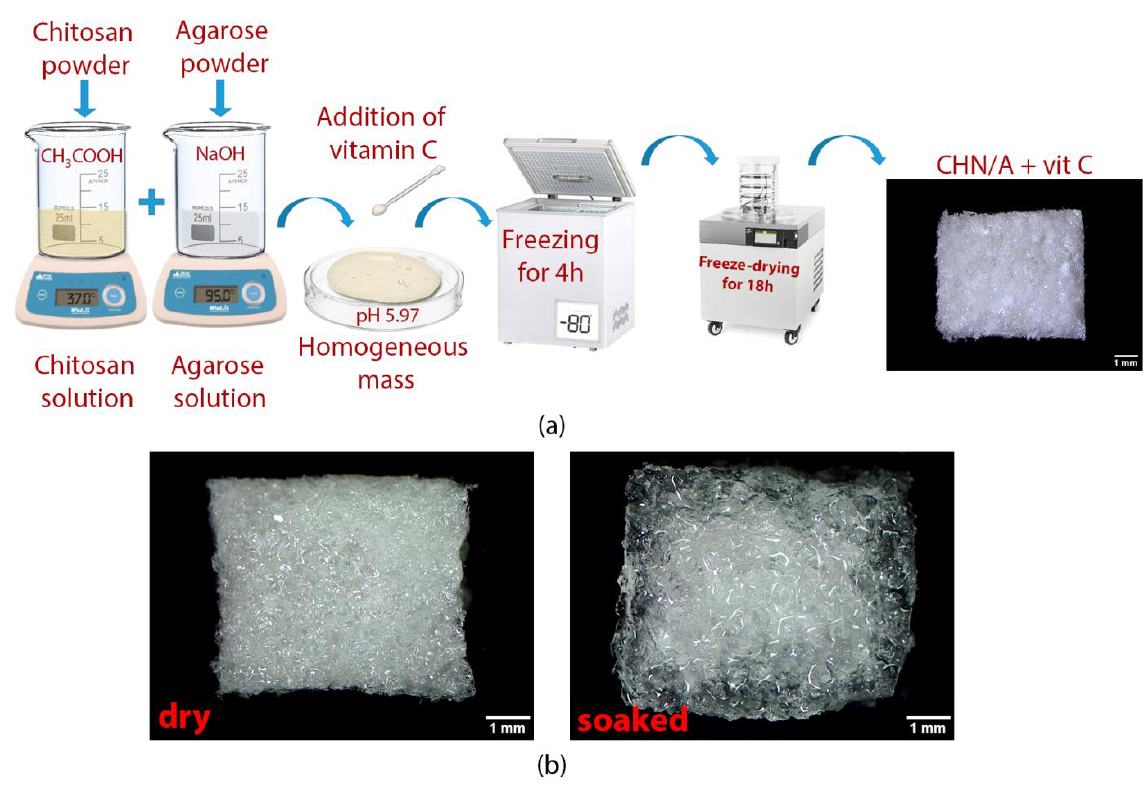
Figure 2. ( a ) A scheme presenting the production steps of porous vitamin C-enriched chitosan/agarose biomaterial; ( b ) Stereoscopic images presenting dry and hydrated dressing material.